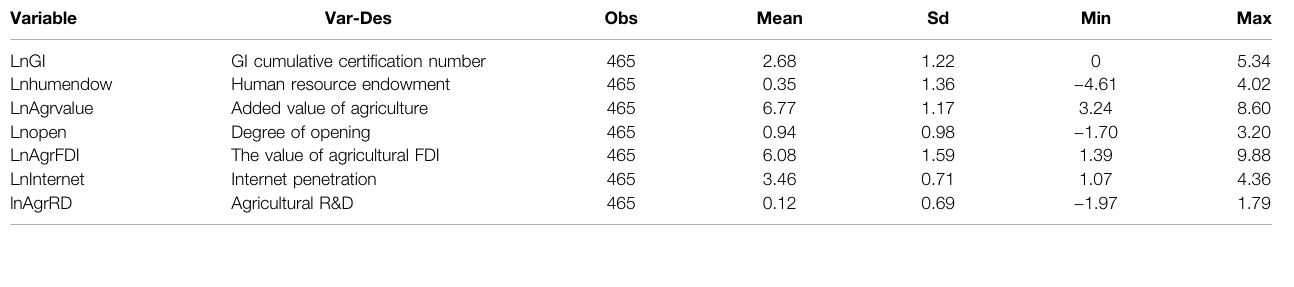
TABLE 1 | Descriptive statistics of the main variables.